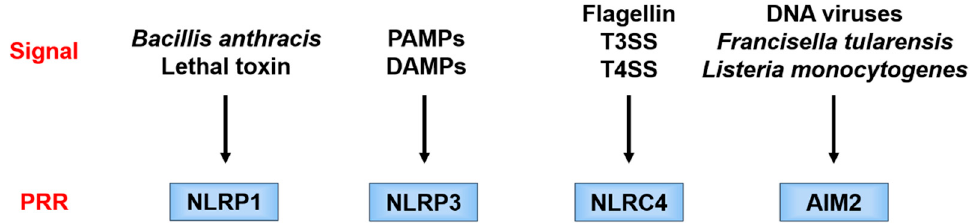
Figure 3. Danger signals recognized by different pattern recognition receptor (PRRs). Each PRR